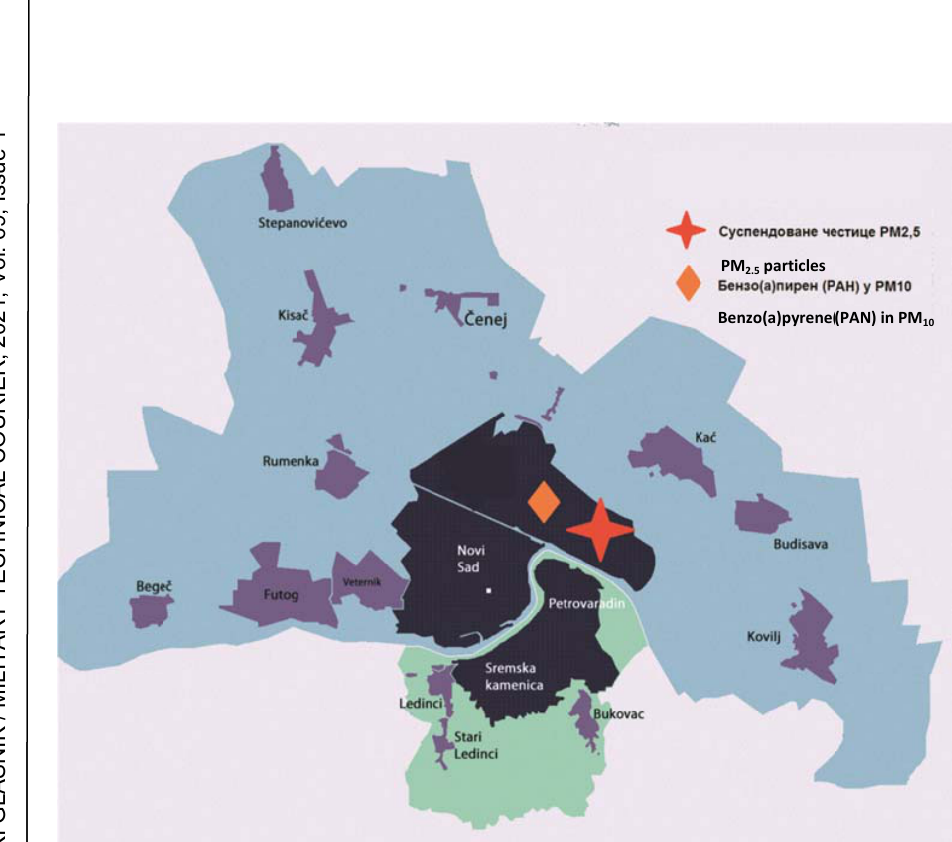
during on Рис . 5 – веществ